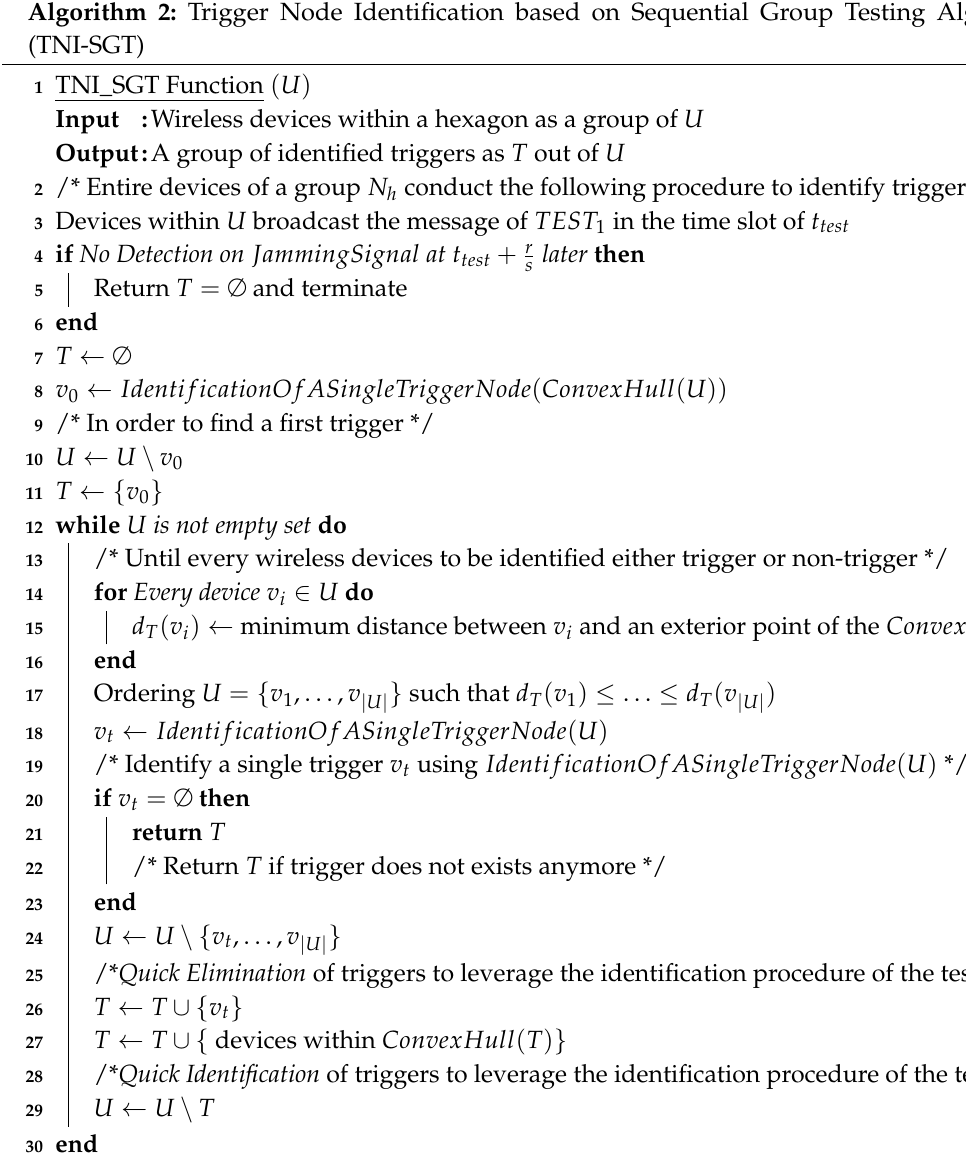
Algorithm 2: Trigger Node Identification based on Sequential Group Testing Algorithm